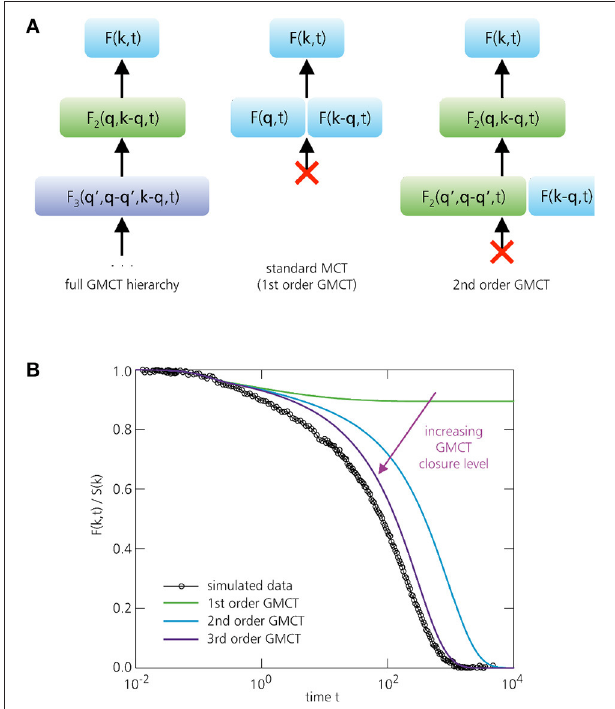
FIGURE 9 | (A) Graphical illustration of the GMCT hierarchy. GMCT seeks to systematically avoid the uncontrolled MCT factorization approximation by developing a new, and formally exact, equation of motion for the unknown memory function. This equation in turn is governed by a new memory function, which is controlled by another memory function, etc. Standard MCT corresponds to the lowest-order (self-consistent) closure of this hierarchy. (B) Microscopic GMCT predictions for F ( k , t ) [ 97] compared to numerical data obtained from computer simulations [ 68] for a system of quasi-hard spheres at packing fraction φ = 0.570 and wavenumber kd = 7.4. These results indicate that the GMCT hierarchy apparently converges and that the theory becomes more quantitatively accurate as the closure level is increased. The figure is adapted from Janssen and Reichman [97] with